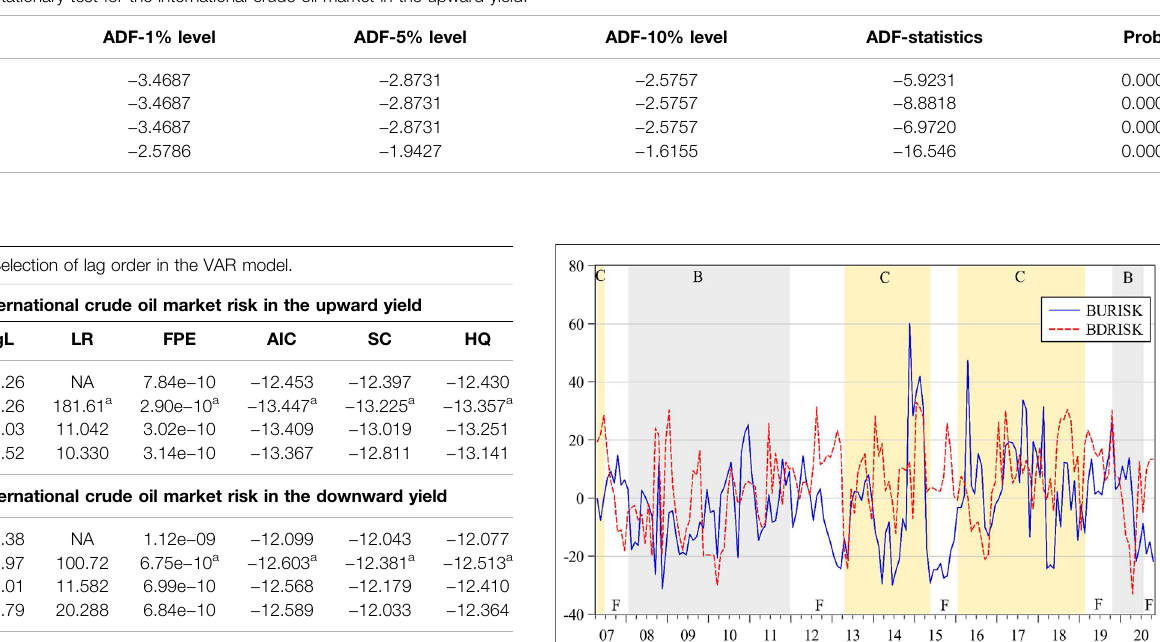
TABLE 2 | Stationary test for the international crude oil market in the upward yield.